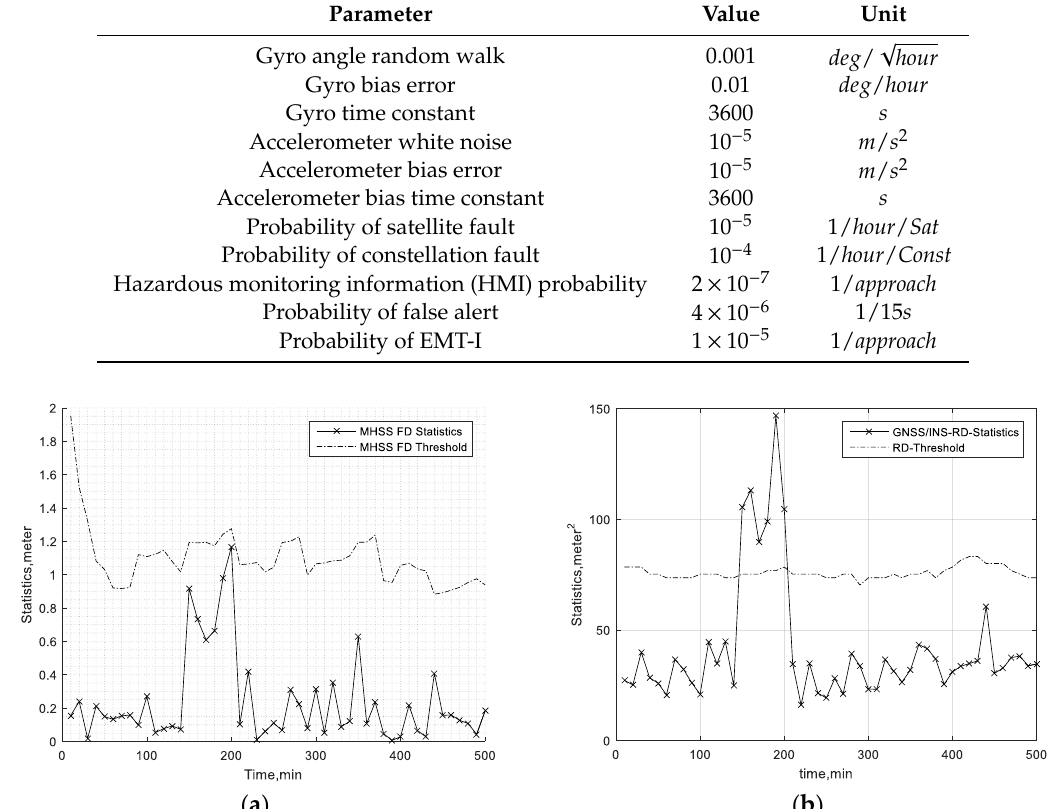
Figure 2. Fault detection (FD) test in the first case. ( a ) Multiple hypothesis solution separation (MHSS) FD test. ( b ) Residual Fault Detection (RD FD) test.